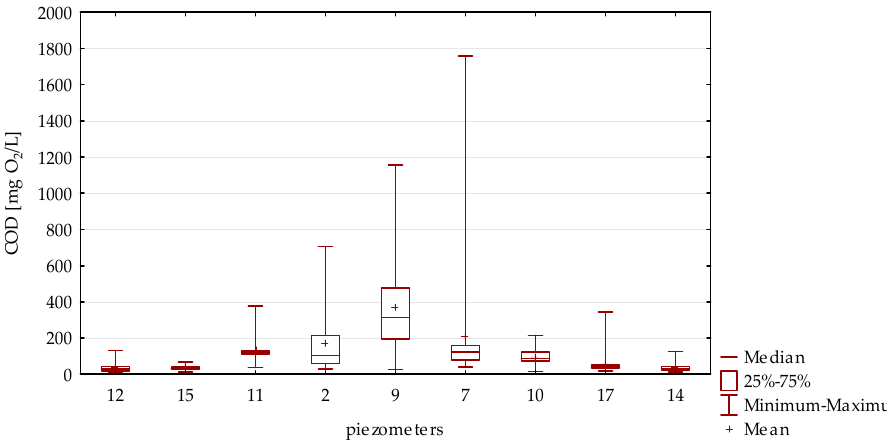
Figure 16. Box-and-whisker plots of the COD level in particular piezometers.